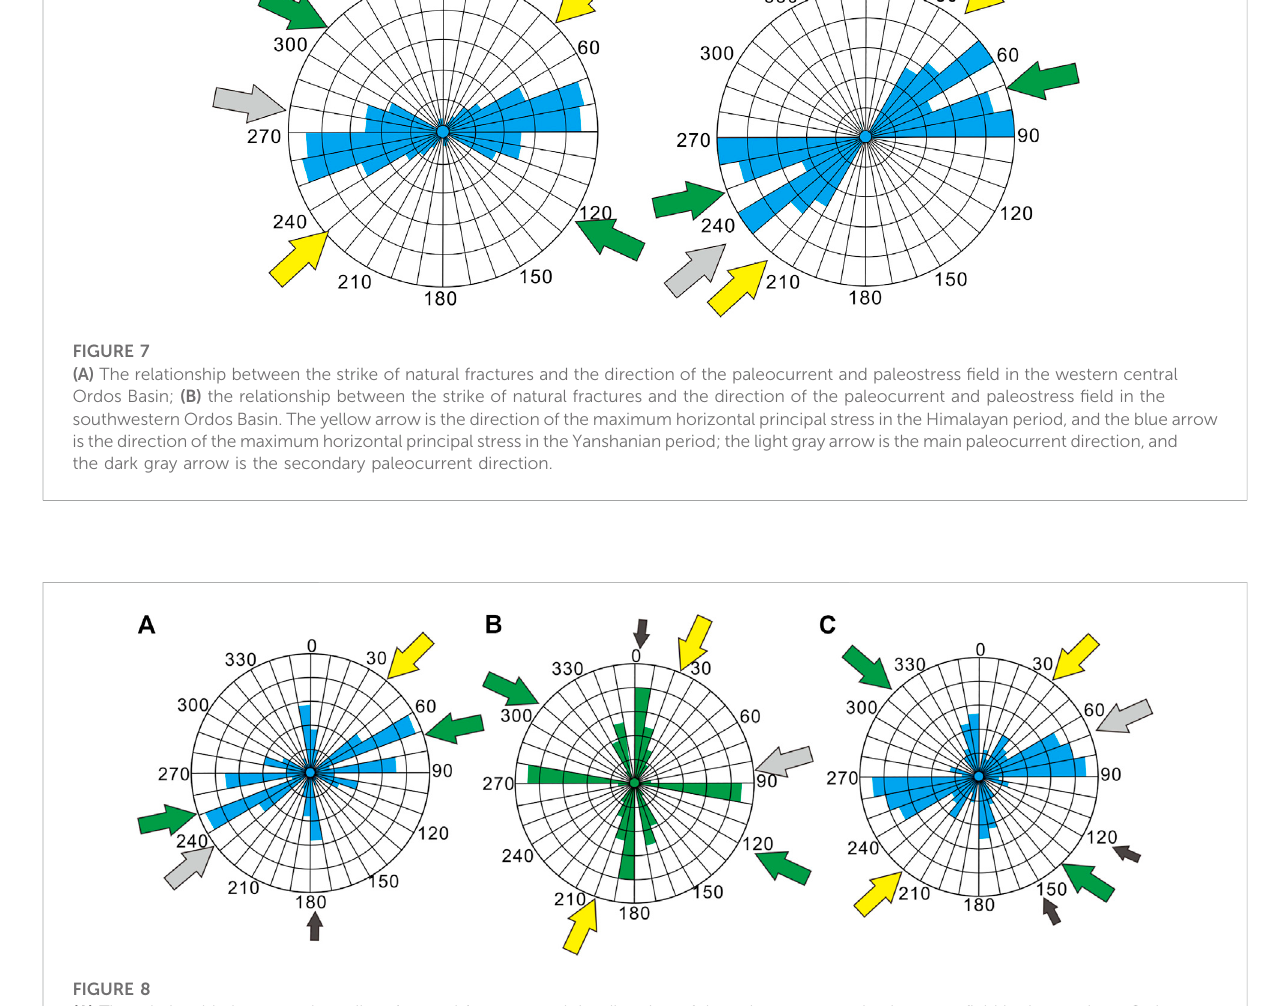
horizontal principal stress in the Yanshanian period; the light gray arrow is the main paleocurrent direction, and the dark gray arrow is the secondary paleocurrent